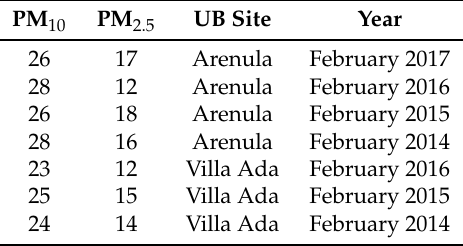
Table 4. Monthly mean values of PM 10 and PM 2.5 ( µ g · m − 3 ) measured in February during the years 2017 (the CARE campaign), 2016, 2015, and 2014 at two urban background stations in the city centre of Rome (Arenula and Villa Ada). Arenula is located 3 km from the CARE site, and Villa Ada is located 7 km from the CARE site. Source: www.arpalazio.net/main/aria/sci/basedati/chimici/chimici.php. PM 10 PM 2.5 UB